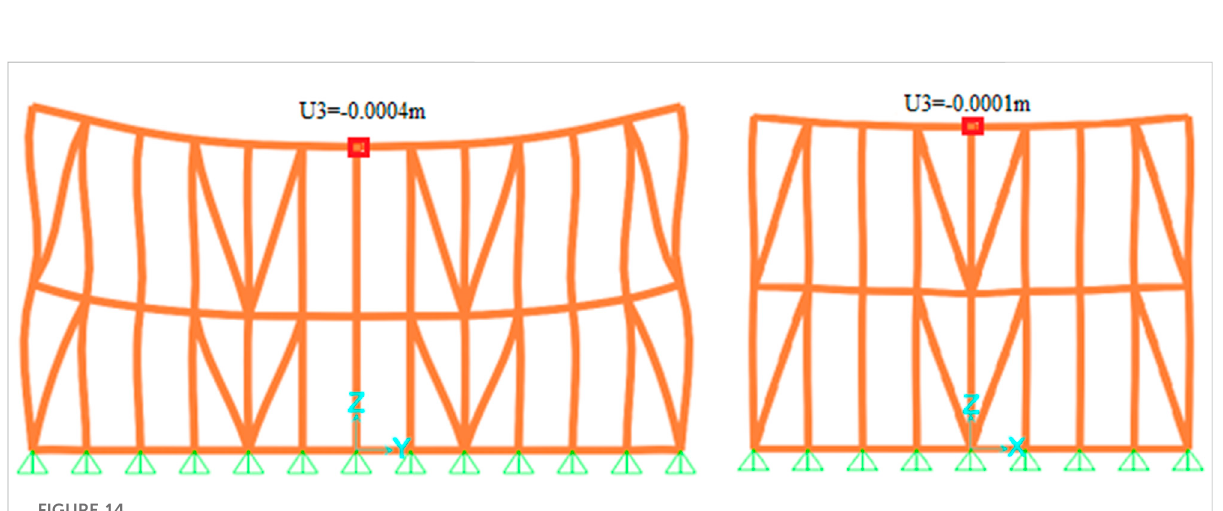
FIGURE 14 Deformations due to gravitational load. U3 represent in the model the maximum displacement in the z axis, that is the gravitational direction. U3 = 4.00 × 10 − 4